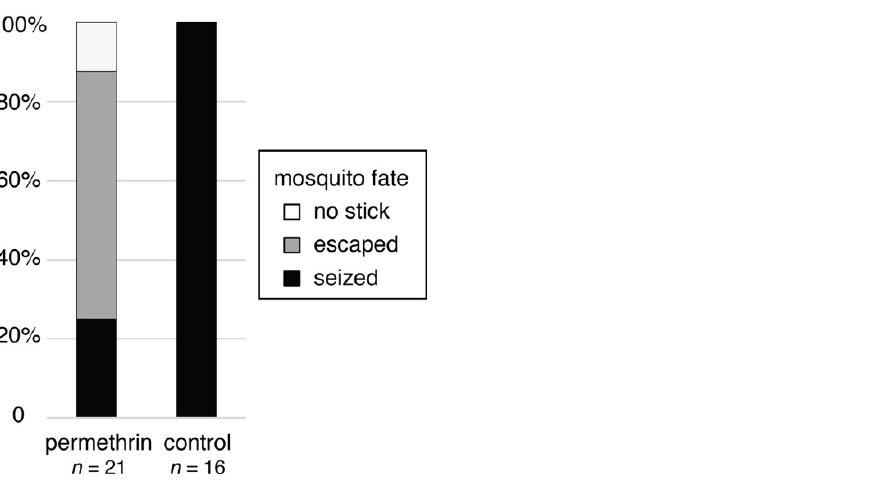
Figure 3. Spiders on permethrin-treated webs captured far fewer mosquitoes than those on control webs.